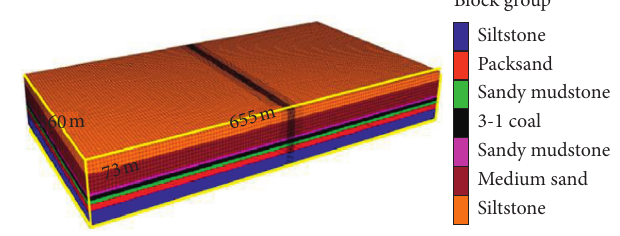
Figure 11: FLAC3D